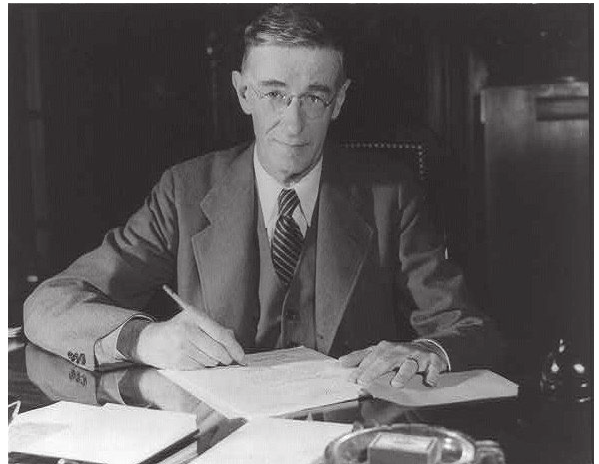
Figure 3. Vannevar Bush seated at his desk (Library of